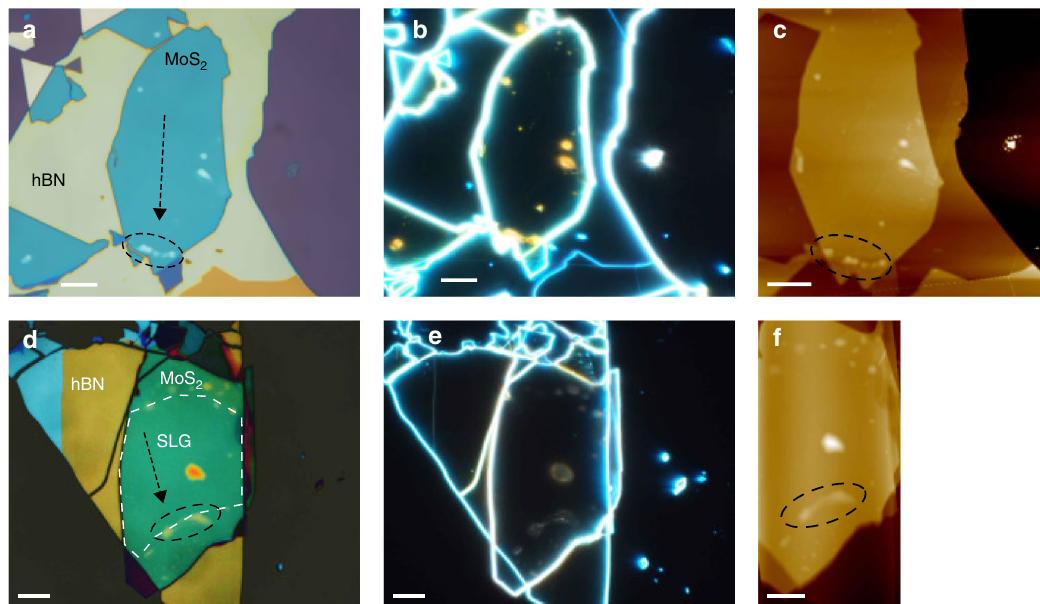
Fig. 3 Blister manipulation in heterostructures containing MoS 2 . a – c Bright fi eld, dark fi eld, and AFM images of MoS 2 /hBN after cleaning. d – f Bright fi eld, dark fi eld, and AFM images of hBN/SLG/MoS 2 after cleaning. In a , c , d , f the black dashed circles mark where the majority of blisters have been pushed. The arrows indicate the direction of the blister cleaning. The white dashed line in d shows the location of the SLG within the heterostructure. Scale